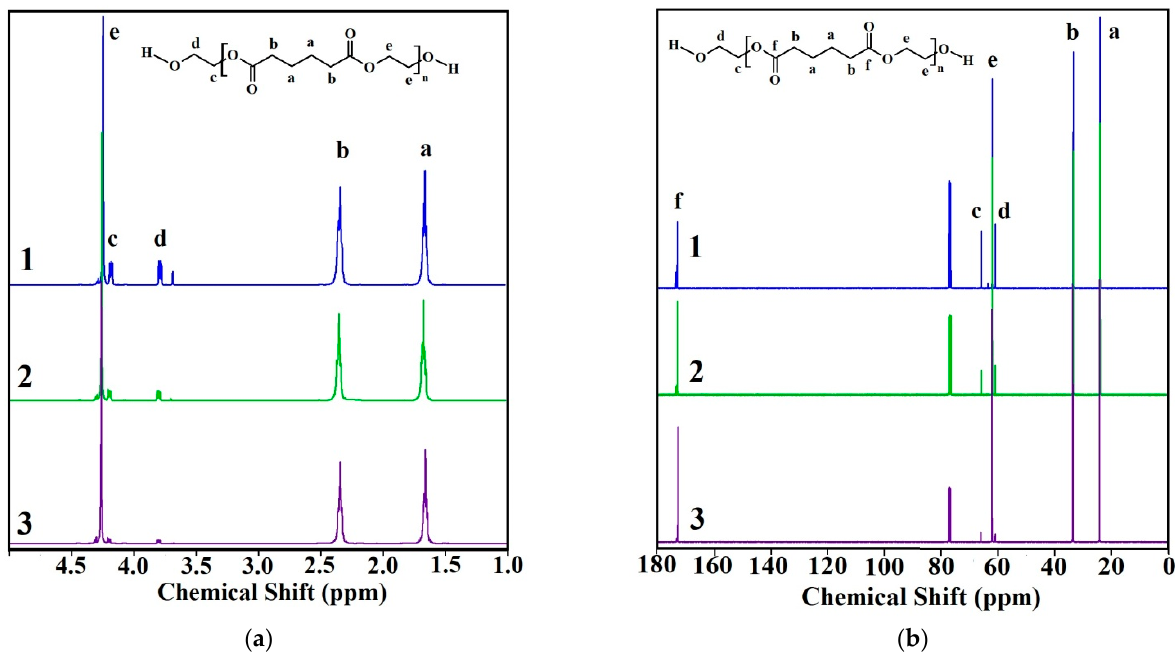
Figure 4. 1 H ( a ) and 13 C ( b ) NMR spectra: 1—OEA 991, 2—OEA 3437, 3—OEA 5505. In the 1 H spectrum, there are two peaks attributed to protons of methylene groups of the adipate fragment- at 1.65 (C(O)-CH 2 -C H 2 -C H 2 -CH 2 -C(O) (a)) and 2.33 (C(O)-C H 2 - CH 2 -CH 2 -C H 2 -C(O) (b)) ppm, respectively. Triplet signals at 3.78 (d) and 4.18 (c) ppm correspond to the protons of methylene groups of the terminal ethylene glycol fragment. This NMR signal interpretation corresponds to the one reported in